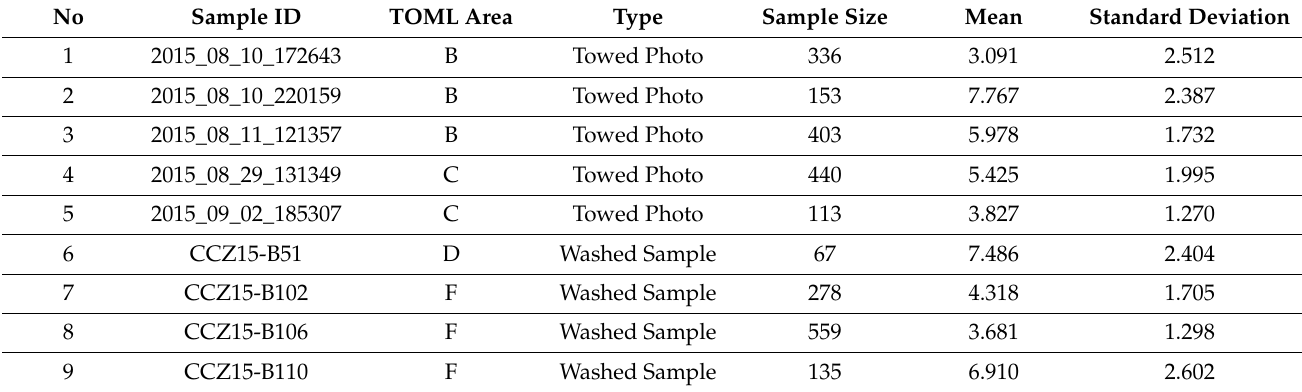
Table 2. Summary of 9 Sets of Samples of Nodule Long Axes used for Goodness-of-Fit Test.